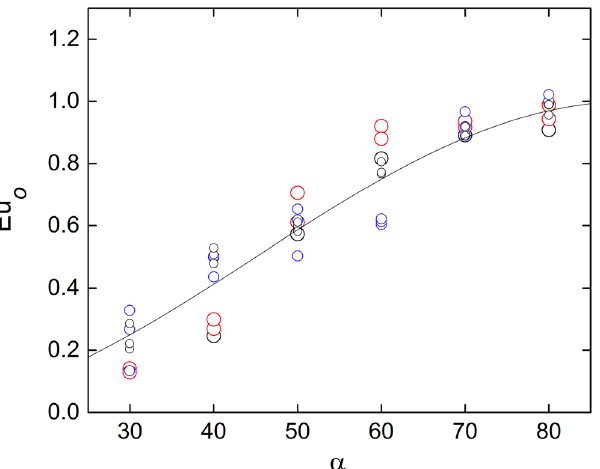
Figure 5. Variation of the wall Euler number at θ = 0 with the inclination angle. The curve corresponds to Eq. (3). Created with Gnuplot 5.4, www. gnupl ot. info.